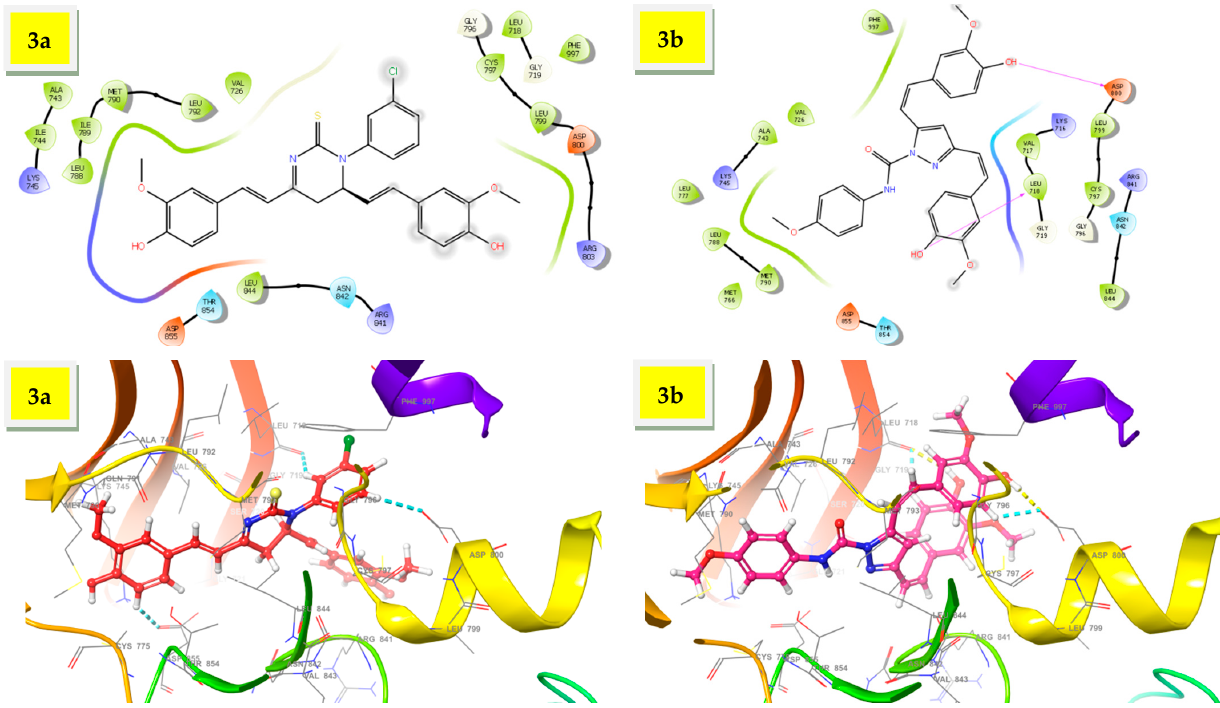
Figure 3. The 3D interaction of ligands, 3a , b within the active site of EGFR.